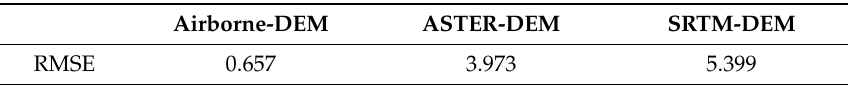
Table 3. RMSE for DEM models.